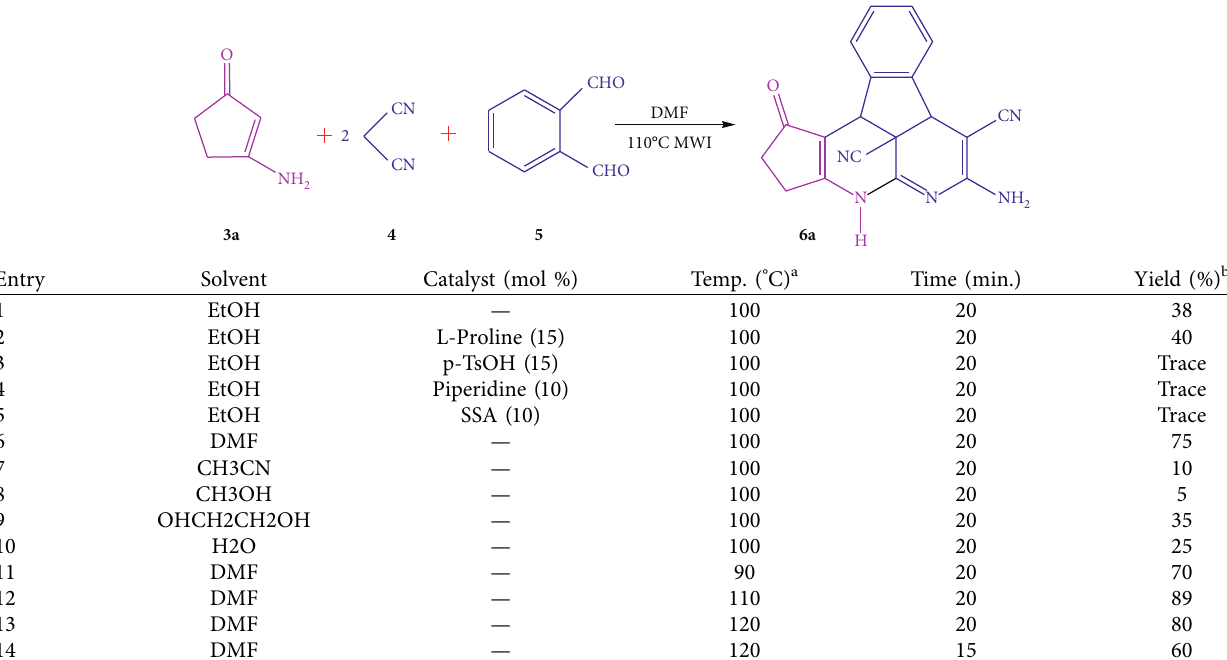
Table 1: Optimization of reaction conditions for synthesis of 6a under microwave